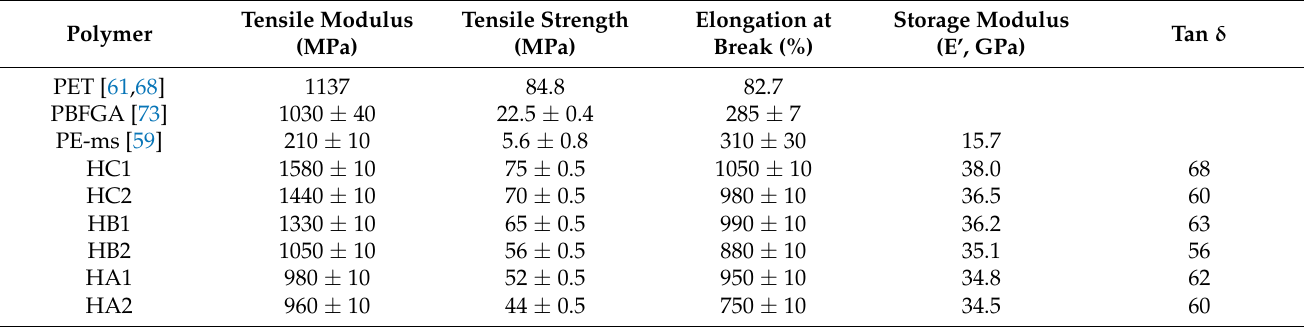
Table 3. Tensile properties of poly(ether-ester)s and compared with other